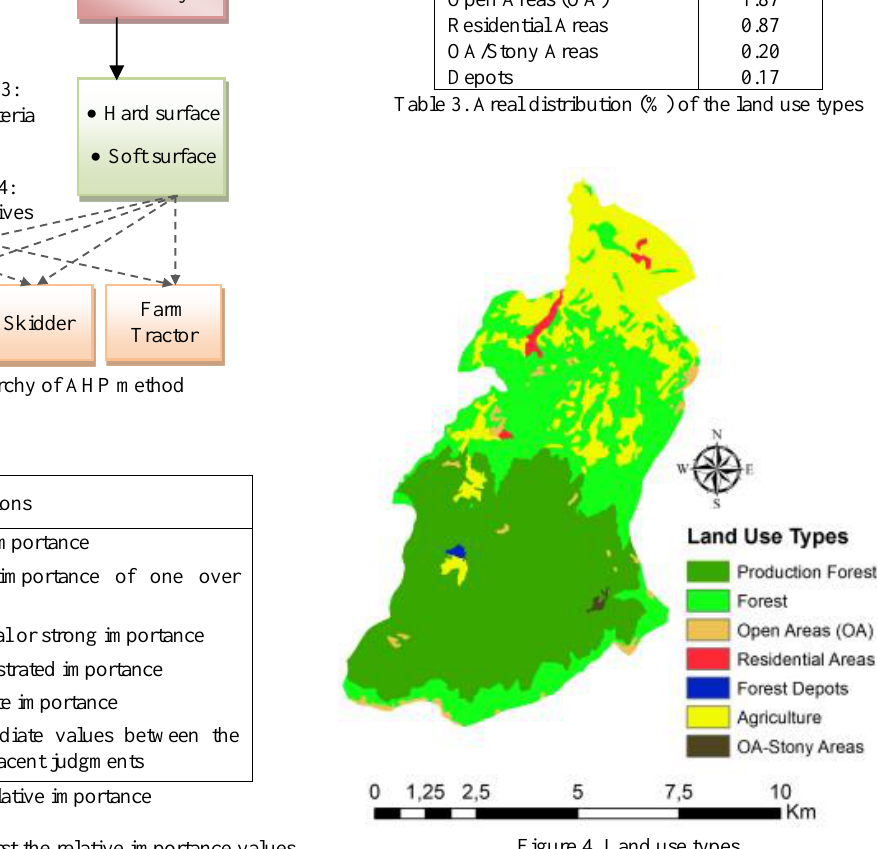
Figure 4. Land use